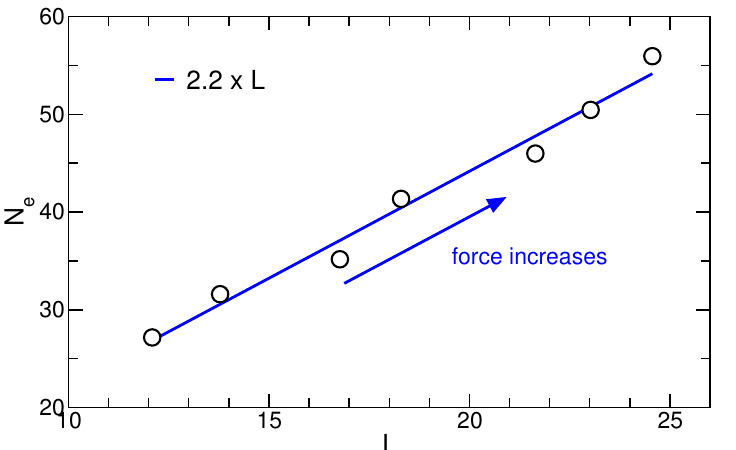
Figure 11. Entanglement length in the under-cooled state at the onset of crystallization vs. stem length in monomer units. The ratio of 2.2 between the two length scales is preserved upon application of